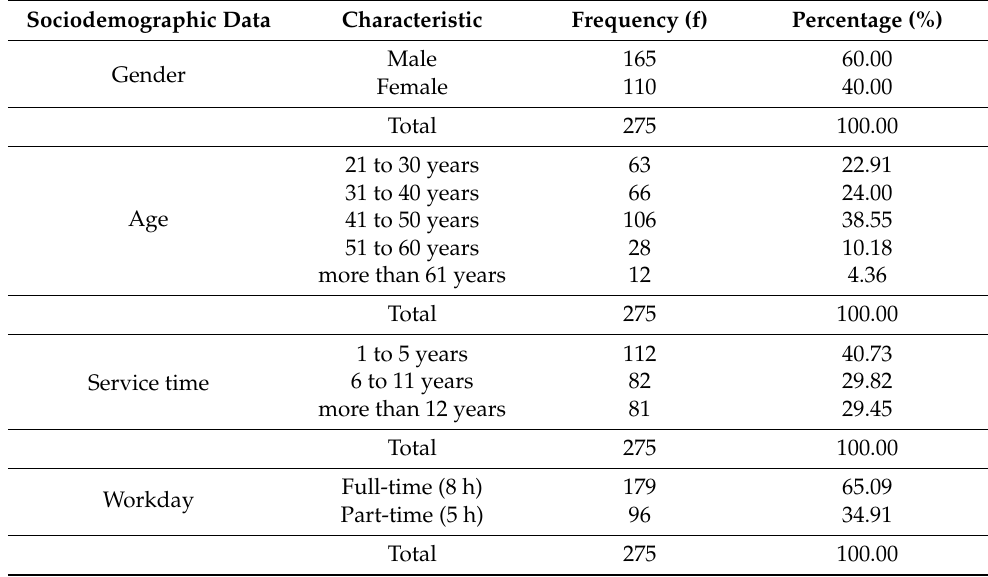
Table 4. Sociodemographic data of the sample.